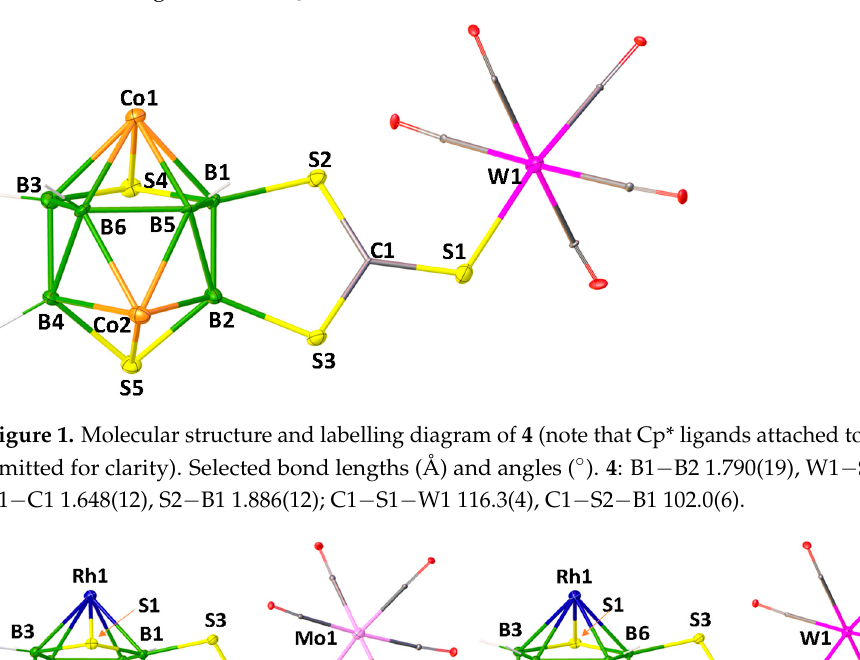
Figure 1. Molecular structure and labelling diagram of 4 (note that Cp* ligands attached to metals are omitted for clarity.) Selected bond lengths (Å) and angles (°). 4 : B1 − B2 1.790(19), W1 − S1 2.529(3), S1 − C1 1.648(12), S2 − B1 1.886(12); C1 − S1 − W1 116.3(4), C1 − S2 − B1 102.0(6).